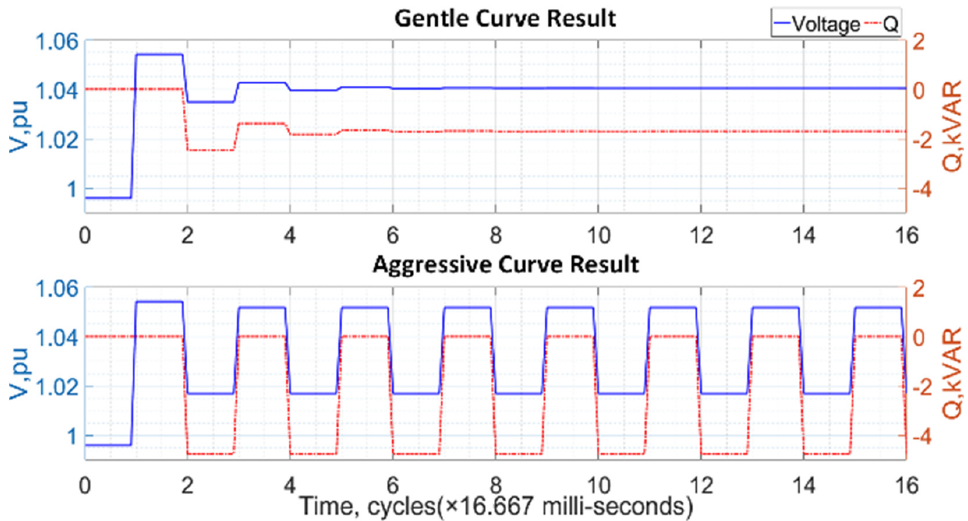
Figure 4. Oscillation of V and Q caused by different volt-var control settings.